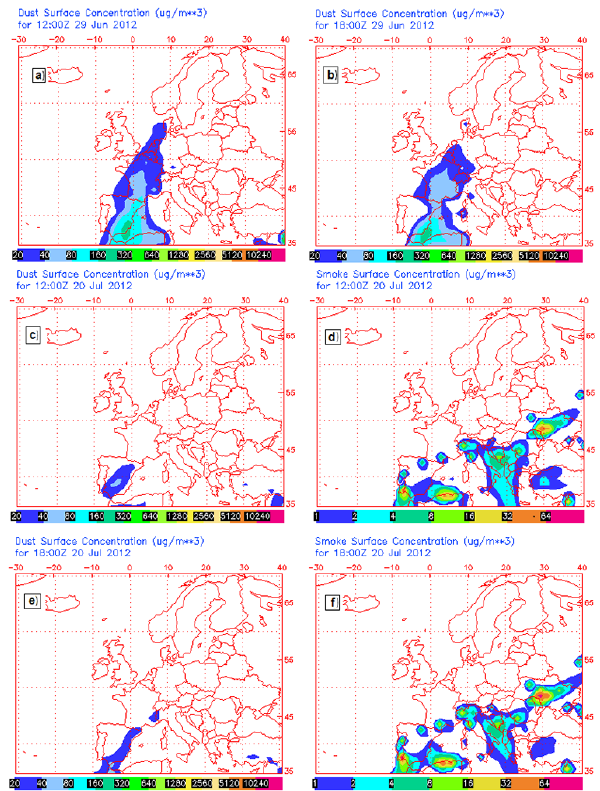
Figure 7. Total surface dust and biomass burning concentration pre- dicted by the NAAPS model for 29 June at (a) 12:00UTC and (b) 18:00UTC, (c, d) 20 July 12:00UTC, and (e, f) 20 July 18:00UTC. Biomass burning concentration is only shown for 20 July since on 29 June there were no concentrations of this type over